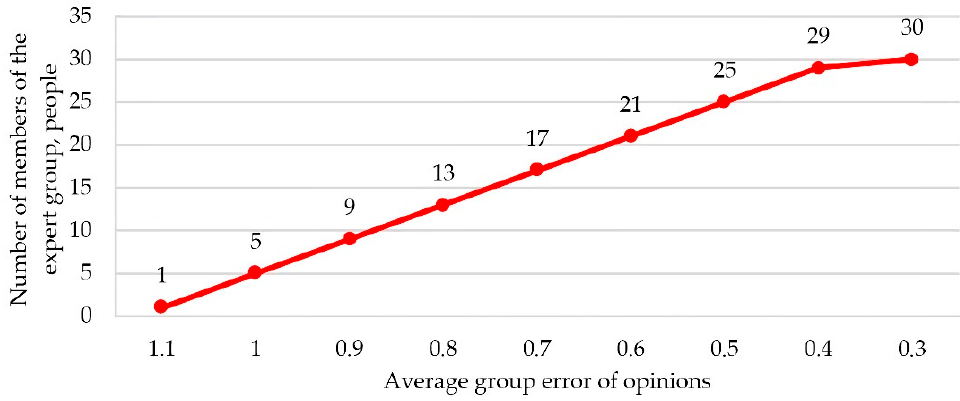
Figure 12. Determination of the minimum required number of experts.